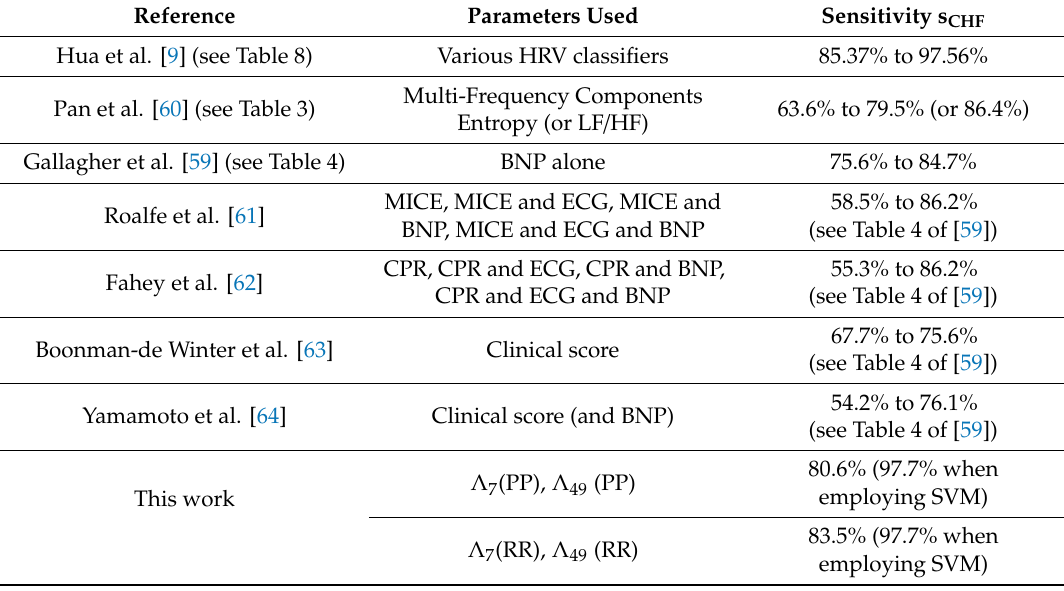
Table 8. Comparison of the present study with the most recent computer aided detection (CAD) systems using Heart Rate Variability (HRV) and the clinical studies discussed in the most recent review [59] to distinguish CHF from H. (LF / HF: LF over high frequency ratio of power spectral density, BNP: B-type